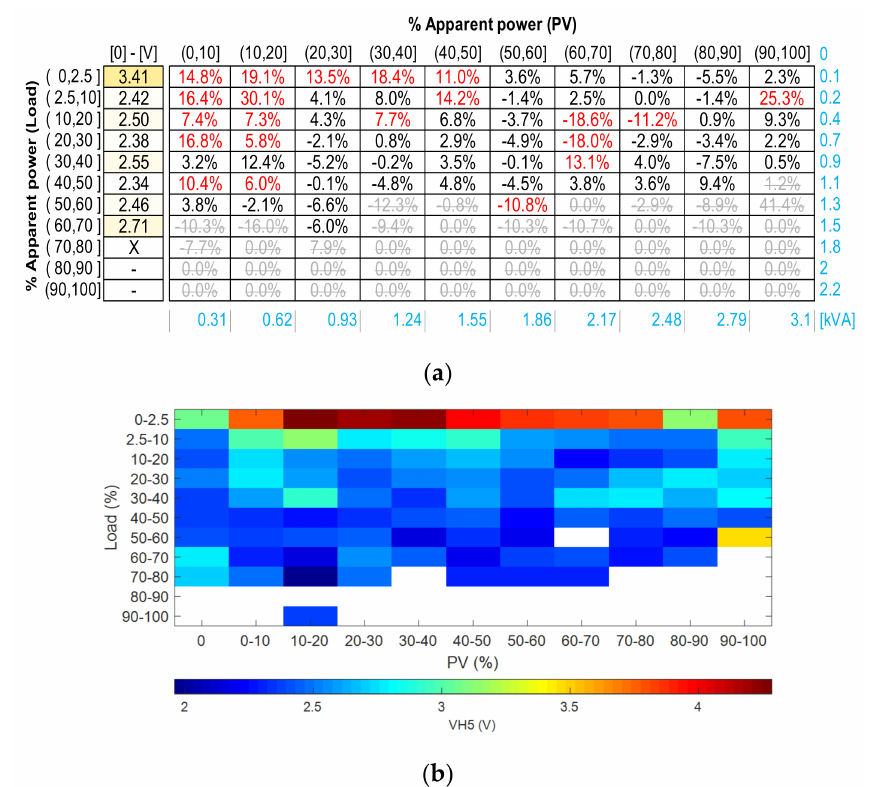
Figure 21. Behaviour of VH5: ( a ) matrix of VH5 values for PVS Of f scenarios and variations of VH5 values for PVS On scenarios of Phase A, and ( b ) average value per